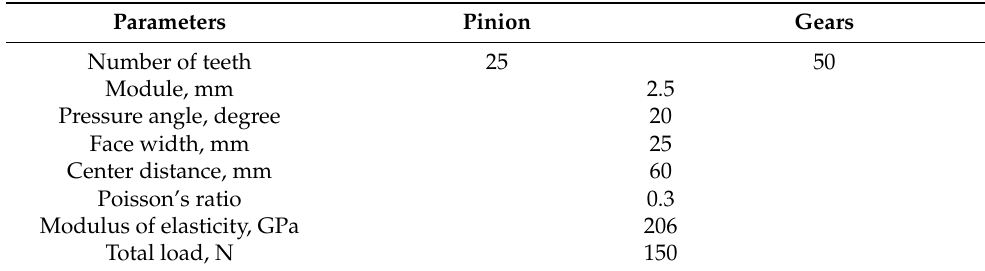
Table 1. Simulation parameters of spur gear